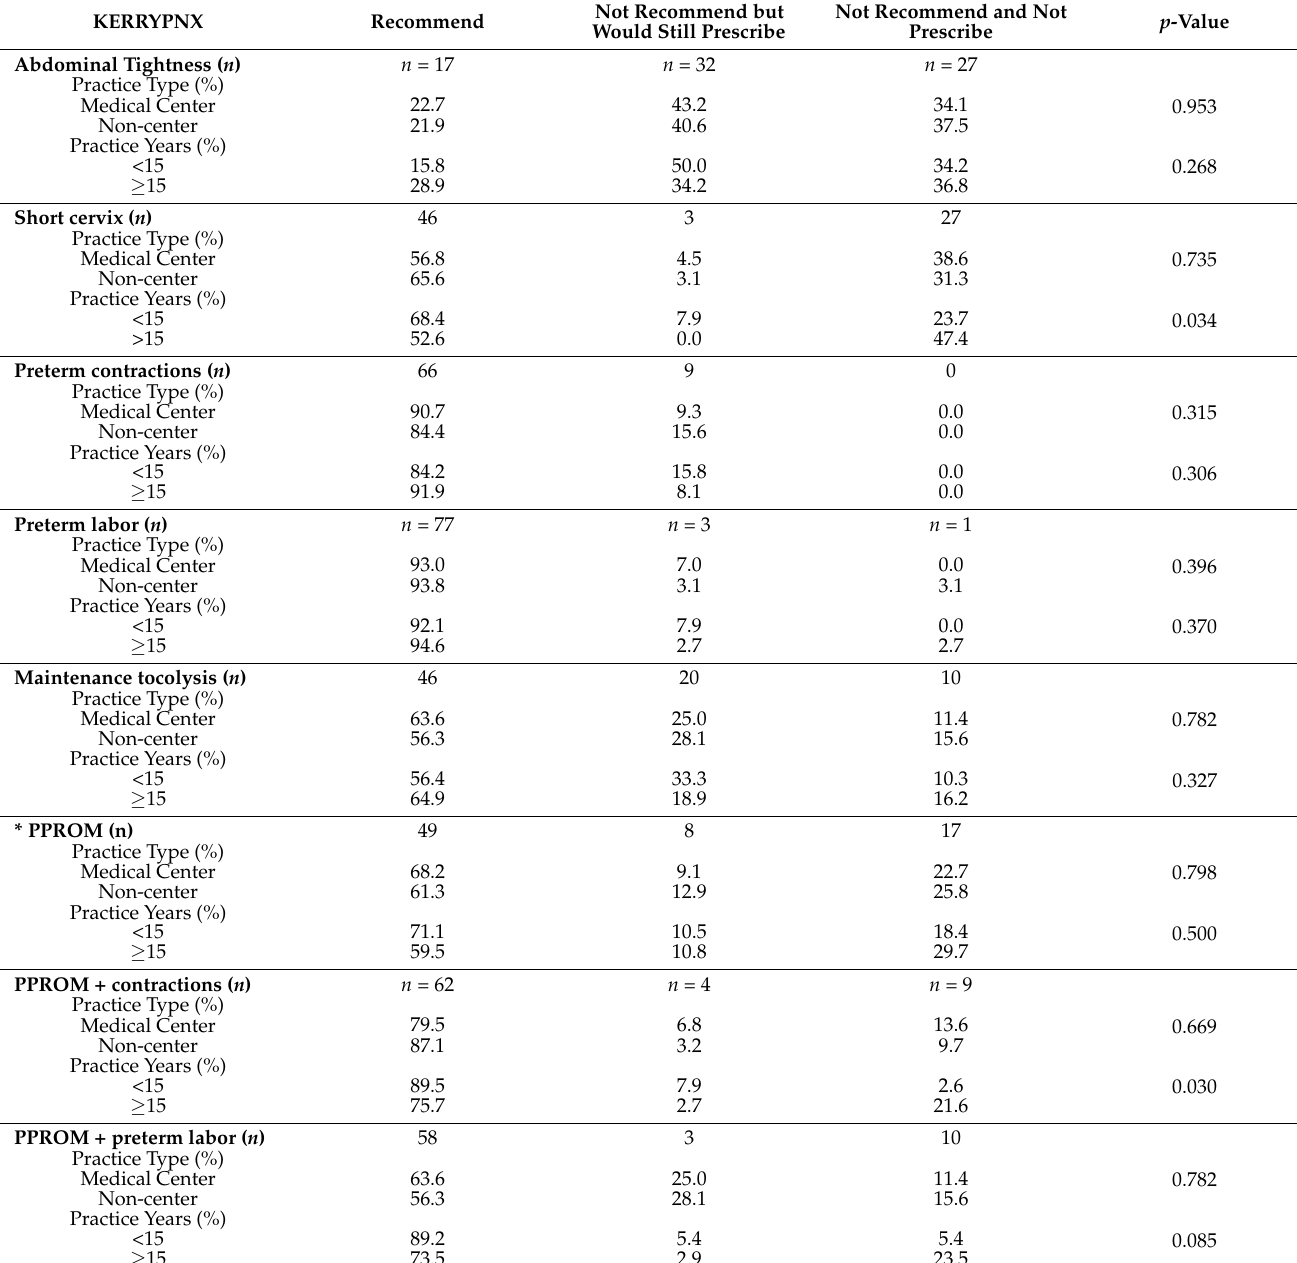
Table 5. Differences between respondents according to medical center/non-center and practicing <15 years and ≥ 15